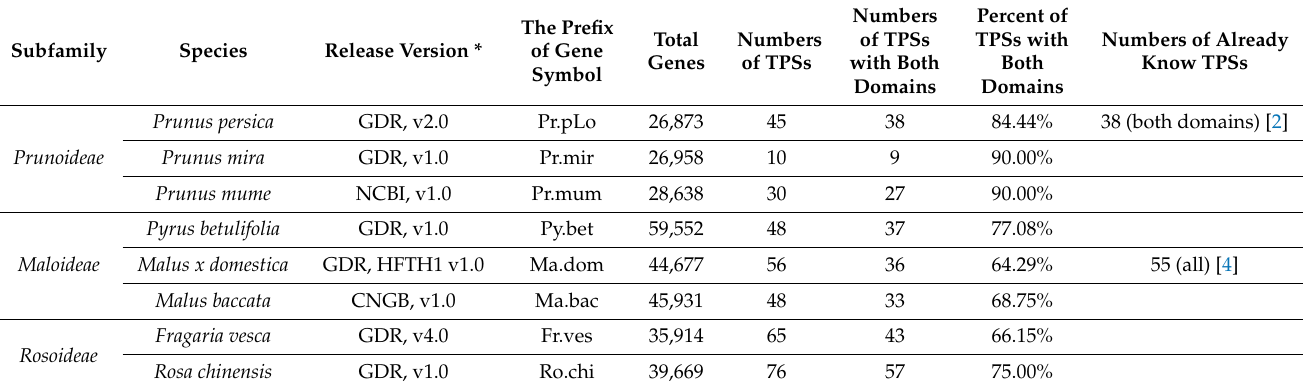
Table 1. Summary of genome information and TPSs of sequenced Rosaceae species used in this